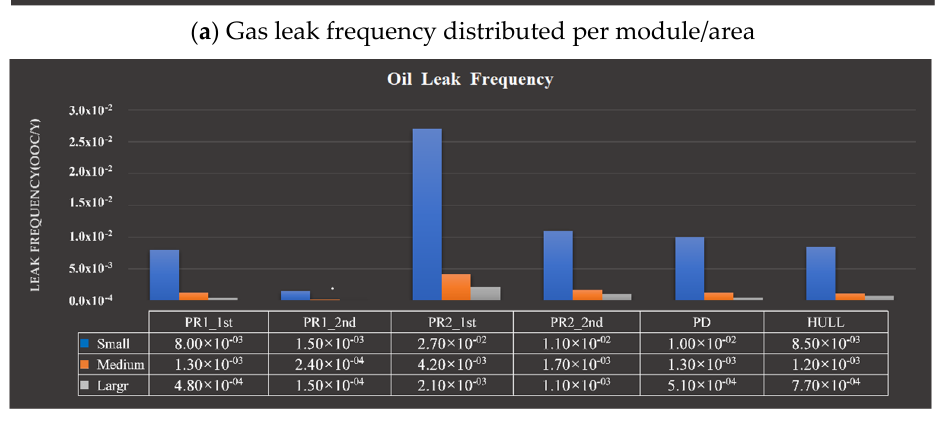
Figure 7. Leak frequency summarized per area. ( a ) represents the gas leak frequency distributed per module/area; ( b ) represents the oil leak frequency distributed per module/area.